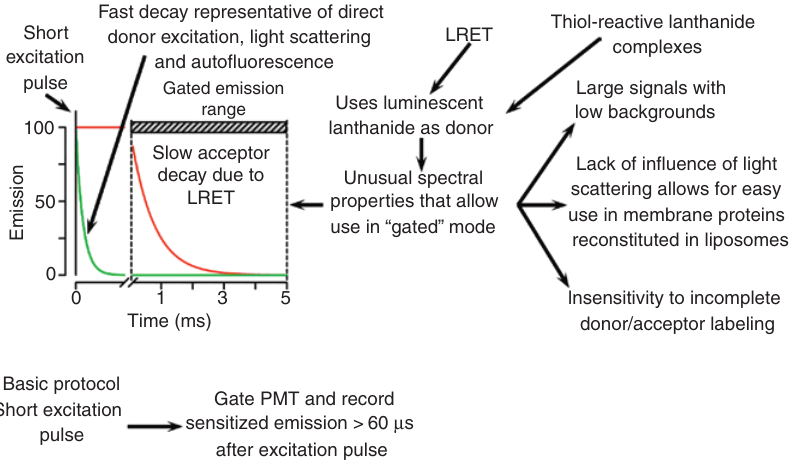
Figure 4: Advantages of LRET and basic experimental protocol. Representative illustration of typical LRET data showing gated emission spectra with a microsecond delay after a 337-nm excitation pulse. Major features of LRET and the associated advantages are